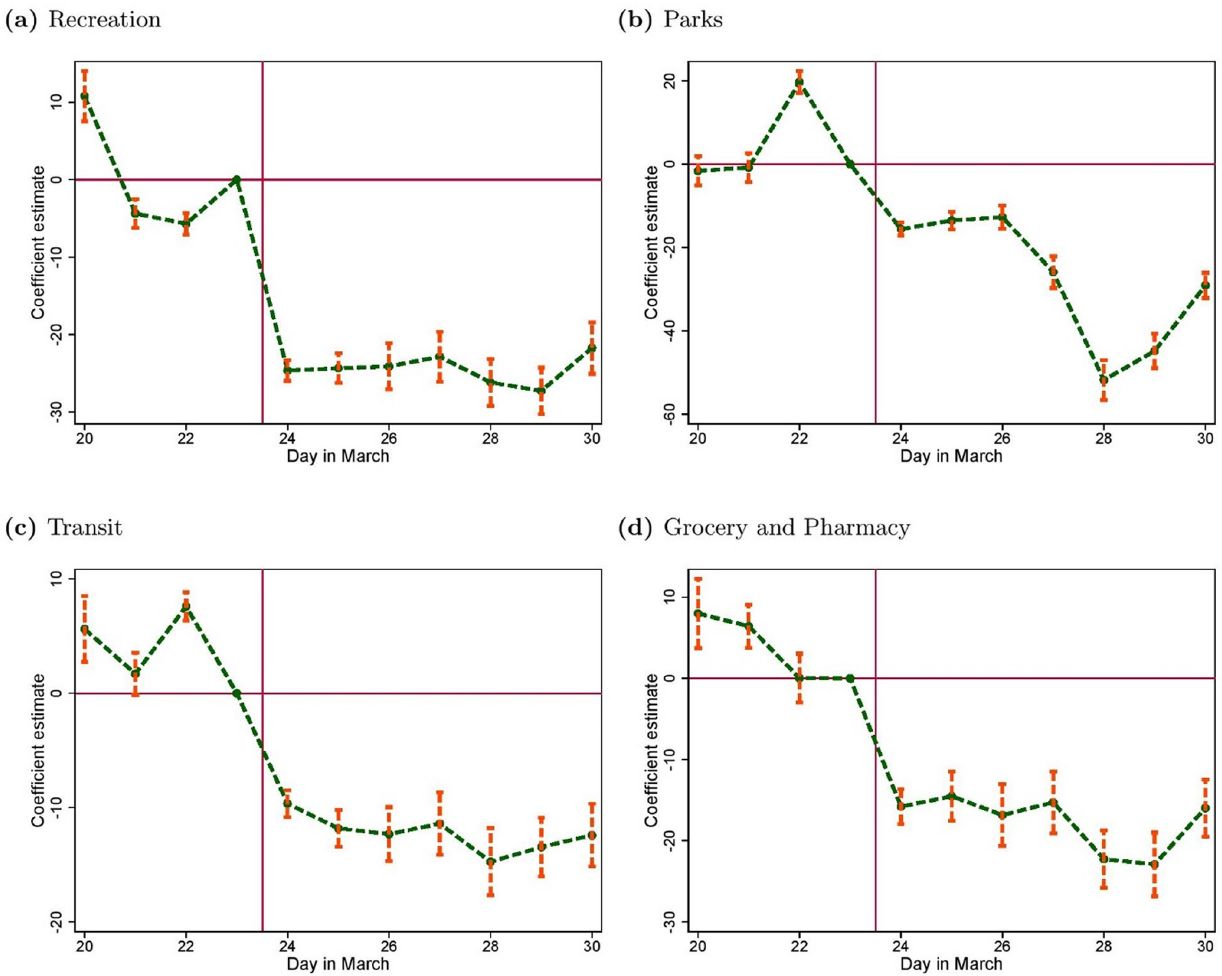
Fig 1. Mobility patterns in the UK. These figures plot the day-fixed effects of a specification that regresses a measure of mobility on days as well as Covid deaths and confirmed cases. The outcome variable is mobility data made publicly available by Google at https://www.google.com/covid19/mobility/. It characterizes in percent how many individuals spend time in (a) recreational areas, (b) parks, (c) transit, and (d) stores and pharmacy relative to a baseline. This baseline is the average number of visit on the same weekday between January 3rd and February 6th. A negative value thus means that there are fewer people at a given place than in the baseline period. The unit of observation is percent and the coefficients have to be interpreted as percentage